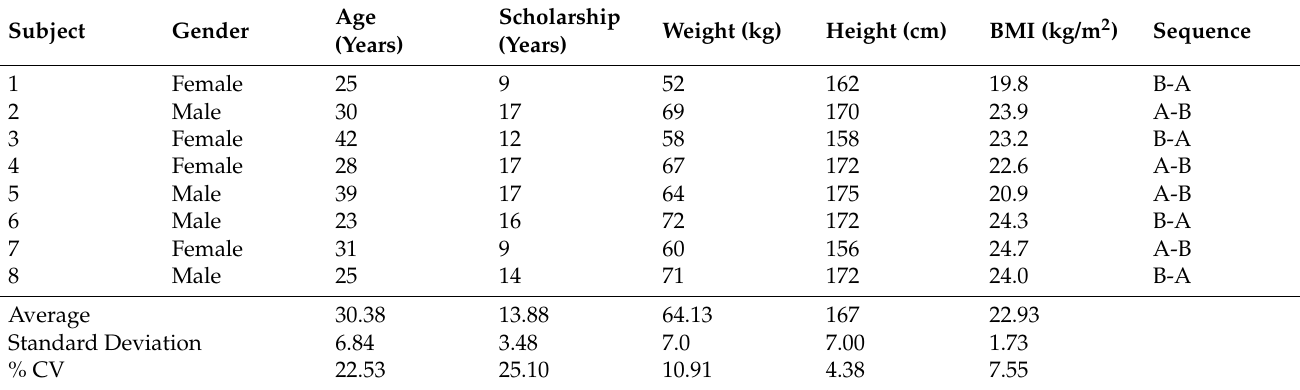
Table 1. Demographic data for DXM-administered patients.